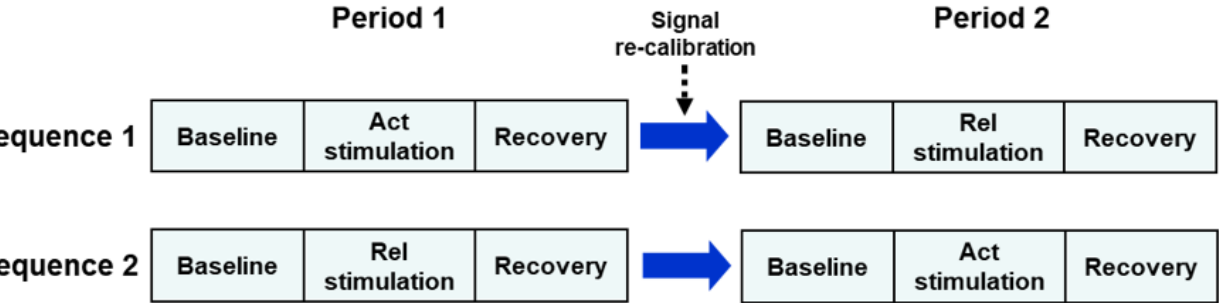
Figure 2. Schematic diagram of the experimental design of the study. Each recording subsection (baseline, stimulation, recovery) lasted 5 min. Act = activating; Rel = relaxing.